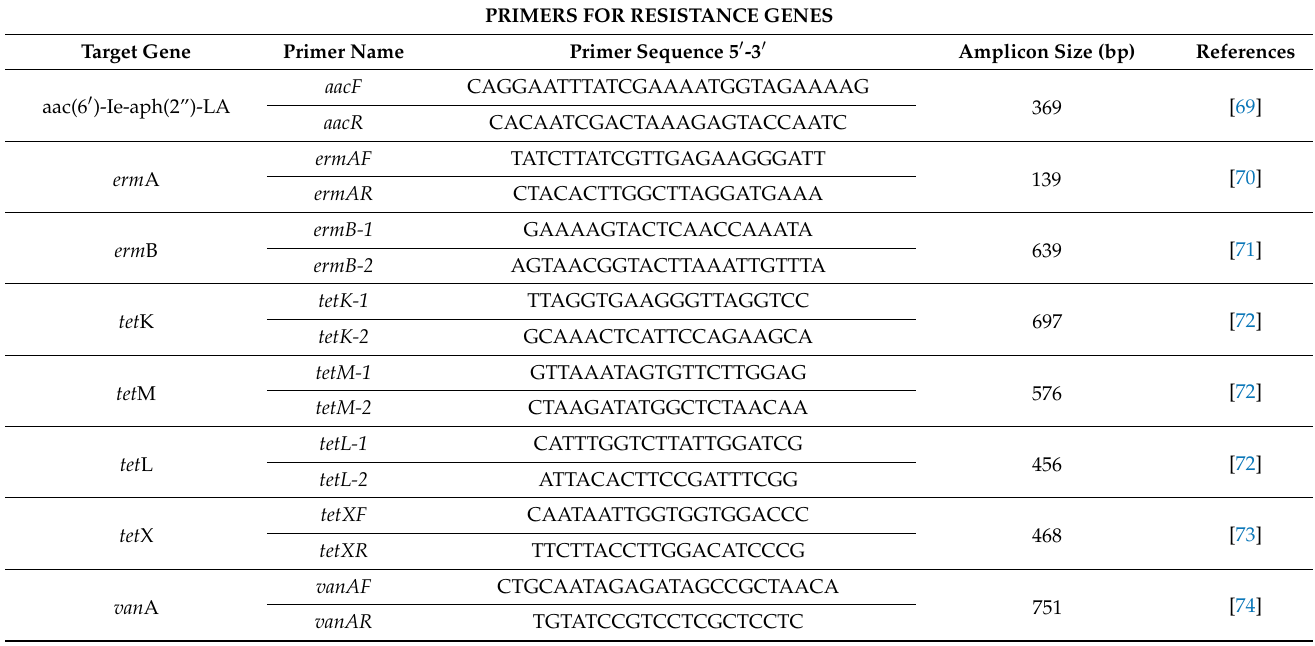
Table 10. Primers used for the Detection of Resistance Genes. PRIMERS FOR RESISTANCE